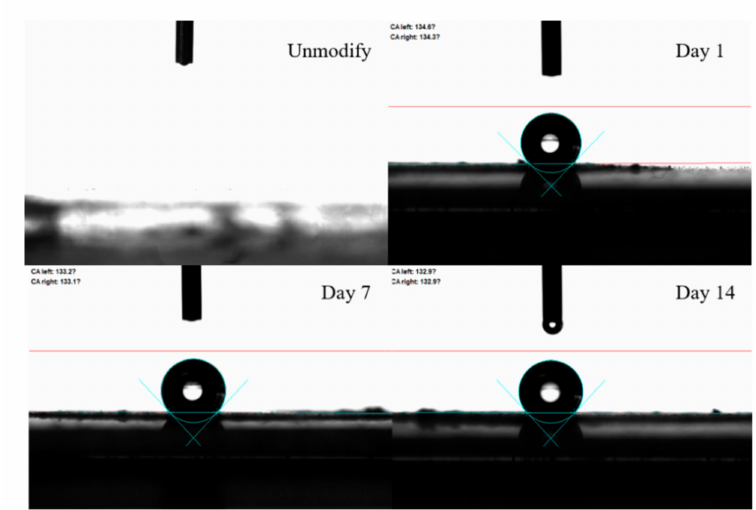
Figure 8. Contact angle of a water droplet on CNC and CNC-PAZO polymers (H 2 O, 5 µ